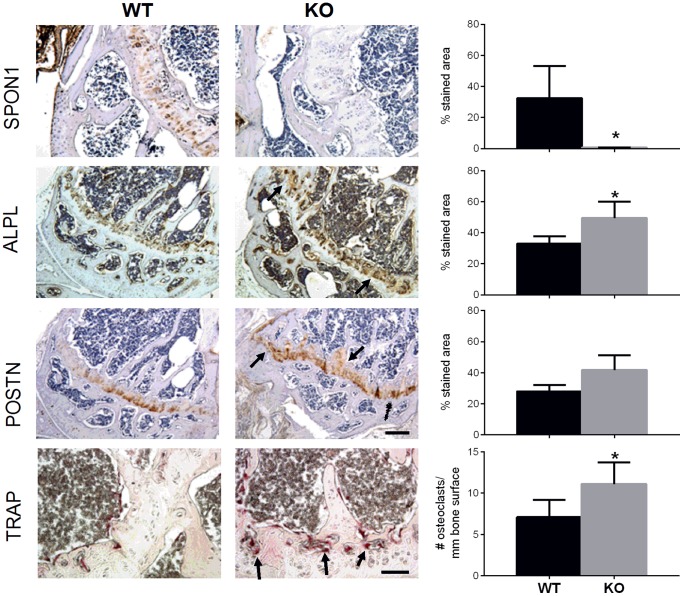

Spon1
−/− mice tibiae exhibit increased staining of markers of bone synthesis and turnover.Immunohistochemical staining of mid-saggital sections of tibia from 6 month old WT and Spon1
−
/− mice with antibodies for F-spondin (SPON1), Alkaline Phosphatase (ALPL), Periostin (POSTN), and tartrate resistant acid phosphatase (TRAP) as a marker of osteoclast activity. Sections were counterstained with either 1% methyl green (TRAP) or hematoxylin. Arrrows indicate areas of increased staining in the epiphyseal cartilage and adjacent trabecular bone of Spon1
−
/− tibiae. Adjacent graphs correspond to quantification of positive stained area (SPON1, ALP, POSTN) and osteoclast number per field (TRAP). Quantification was performed on 4 sections per specimen, and values represent the average of 4 mice per genotype. * = P<0.05. Scale bars; 200 µm for antibody stainings and 100 µm for TRAP staining.